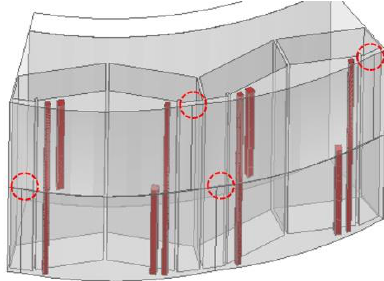
Figure 18. Rotor with asymmetric air hole structure.